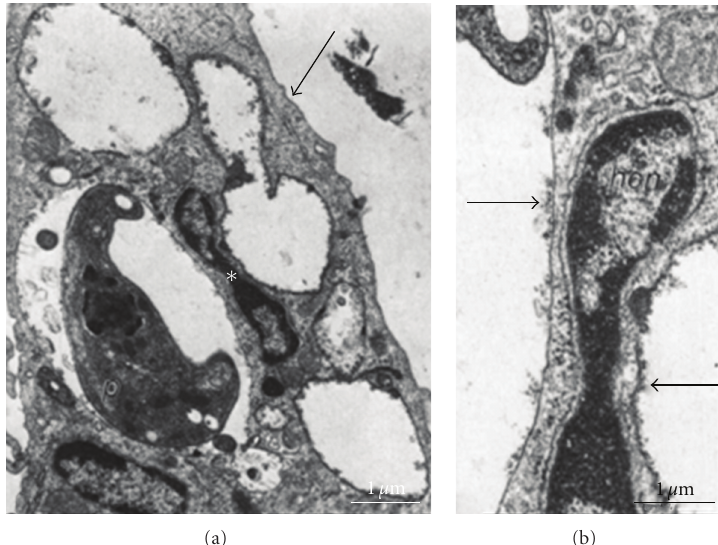
Figure 5: Macrophages first labeled with ferritin-ConA at 4 ◦ C, incubated with T. cruzi at 4 ◦ C, and then incubated for 30 min at 37 ◦ C, after which the cultures were fixed. The ferritin particles (arrows in (a) and (b)) associated with the membrane of vacuoles without parasites are uniformly distributed, showing a patchy distribution in those vacuoles that contain parasites. (b) High magnification of the area marked with an asterisk in (a), showing in detail the membranes of two di ff erent vacuoles. hcn, host cell nucleus; p, parasite; and pvc, parasite-containing vacuole. Bars = 1 μ m (after